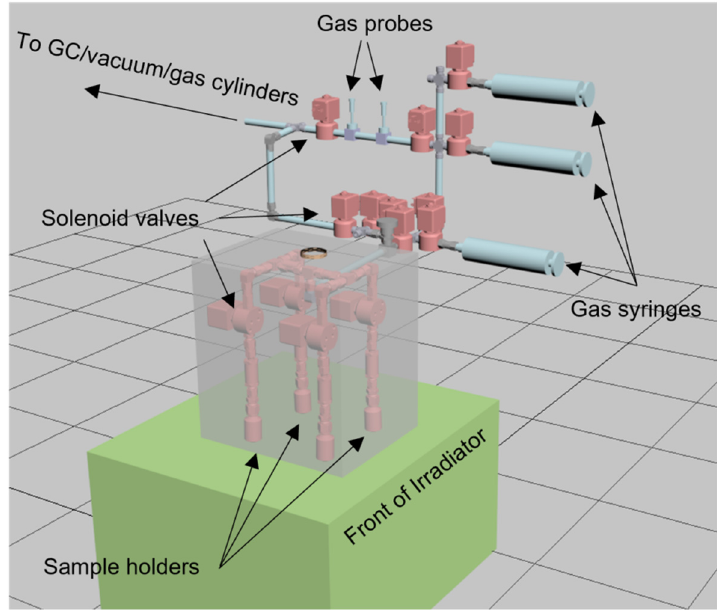
Figure 12. Illustration of a particular configuration of SMORES components to facilitate four parallel studies involving the dynamics of gas and liquid phase radiolysis in the presence of metal oxides. The grey semi-transparent cube illustrates the approximate volume of the DCF 60 Co irradiator. The 60 Co rods are located at the back of the irradiator and the assembly that sits outside of the grey irradiator volume makes use of sample ports in the irradiator shielding.